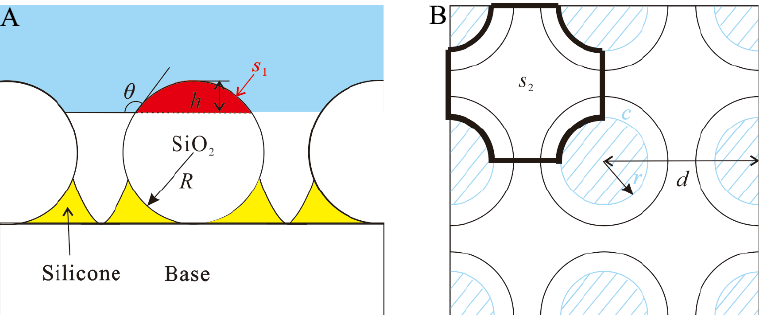
Figure 7. Schematic diagram of microstructure-supported droplets. ( A ) Front view; ( B ) top view. According to the critical three-phase contact line density, the critical point from the Wenzel state to the Cassie state is obtained, and the center distance d between the mi- crospheres is 5.13 µ m. At this time, the gas-liquid contact area S 2 is 14.08 µ m 2 , and the theoretical maximum contact angle size obtained by substituting the data into Equation (3) is 150 ◦